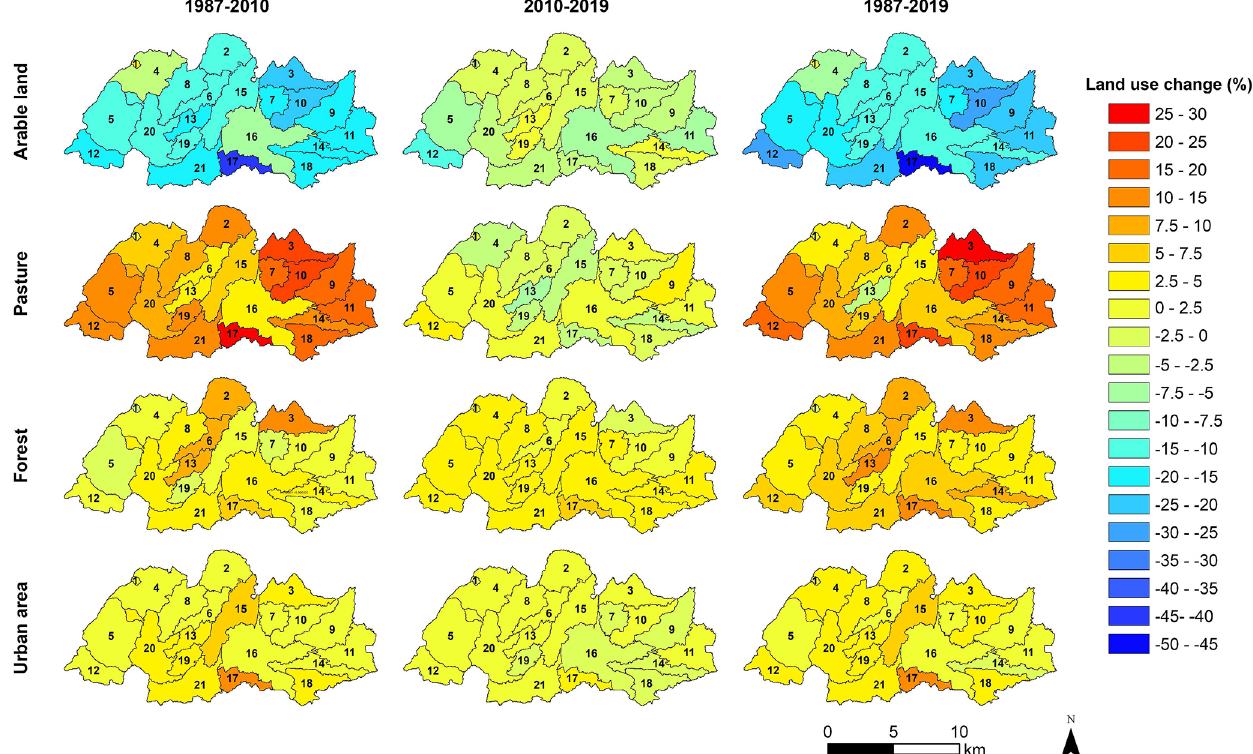
Figure 5. Spatial distribution patterns of the changes in each land use type between the years 1987, 2010, and 2019.